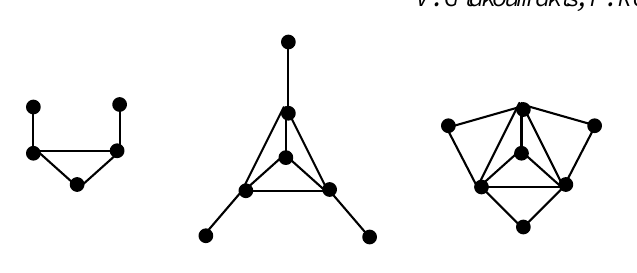
Fig. 1. Bull, urchin and